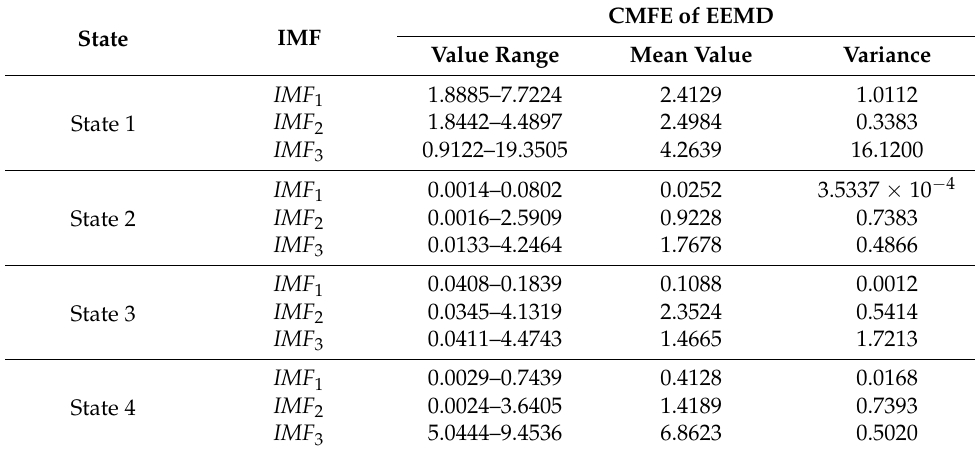
Table 6. CMFE evaluation parameters of EEMD in four